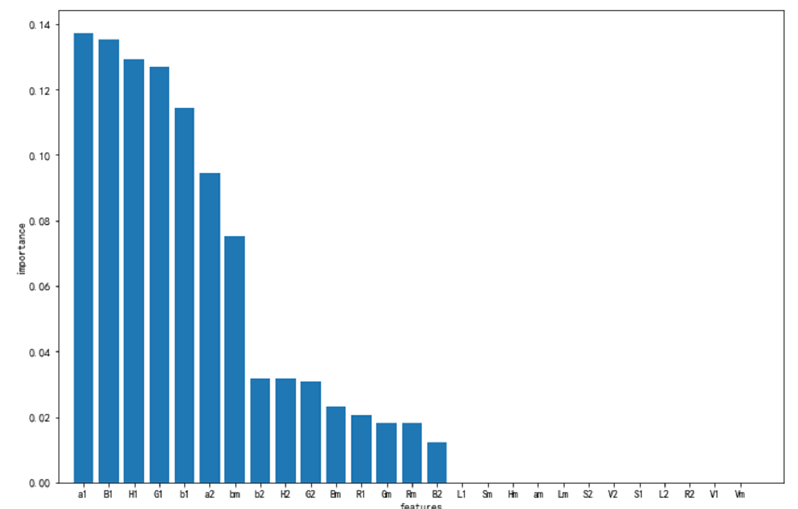
Figure 6. Importance of color features to the classification result ranking diagram.